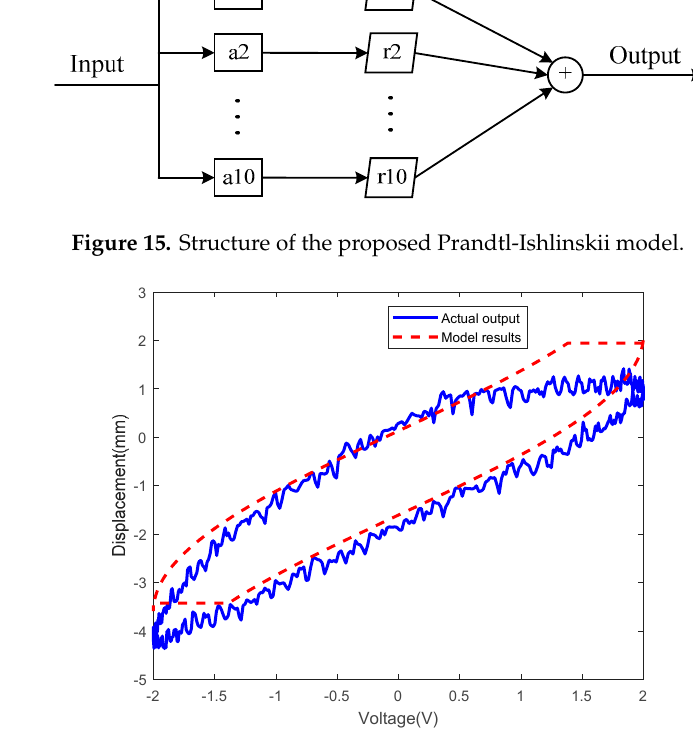
Figure 15. Results of the Prandtl ‐ Ishlinskii modelat sinusoidal actuating voltage with amplitude of 2V and frequency of 1/2 π Hz.